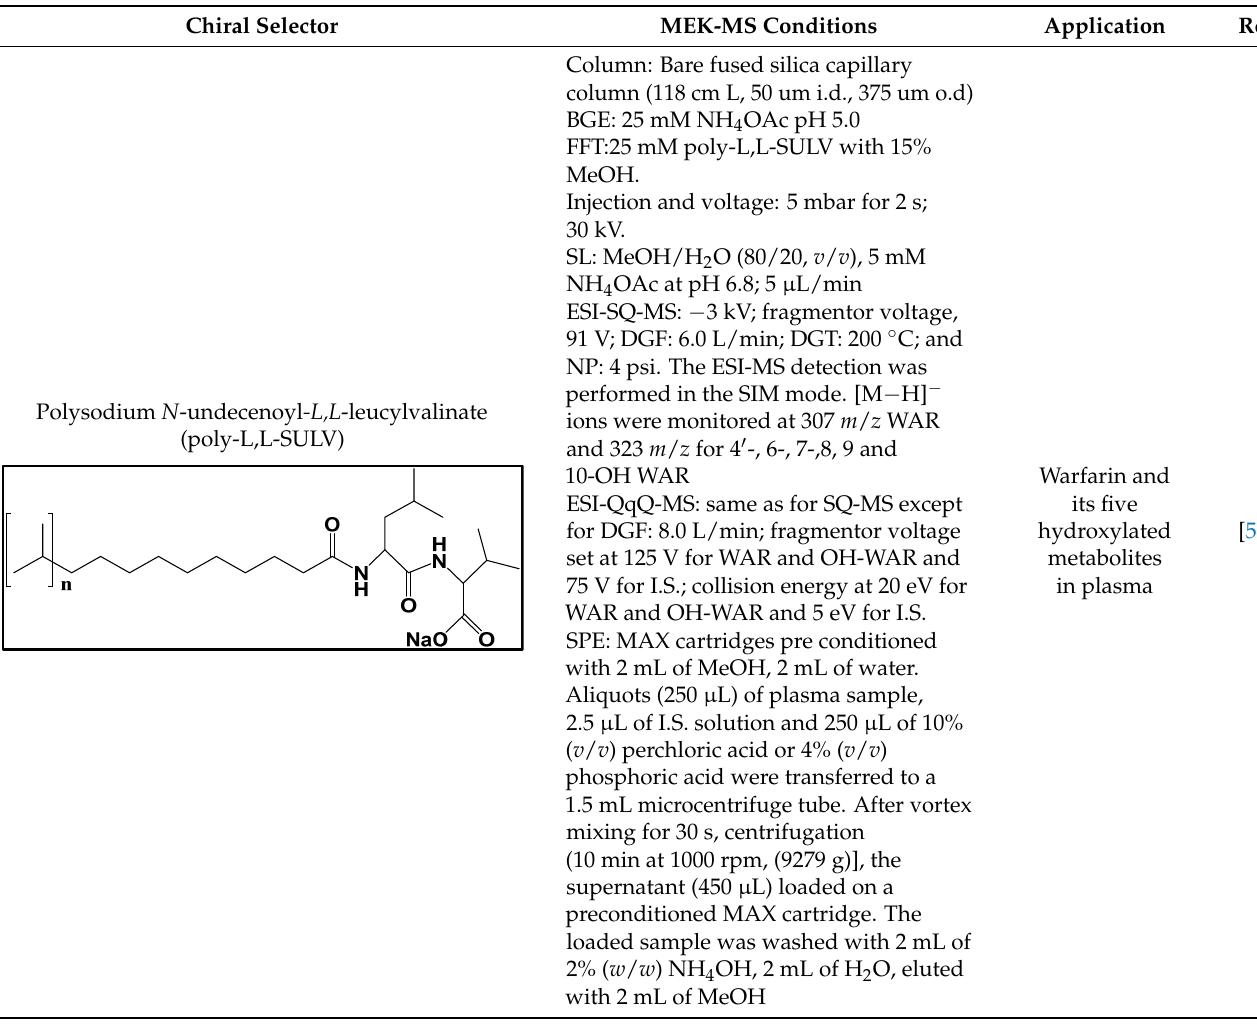
Table 2. Different types of chiral selectors and their applications in MEKC-MS. Chiral Selector